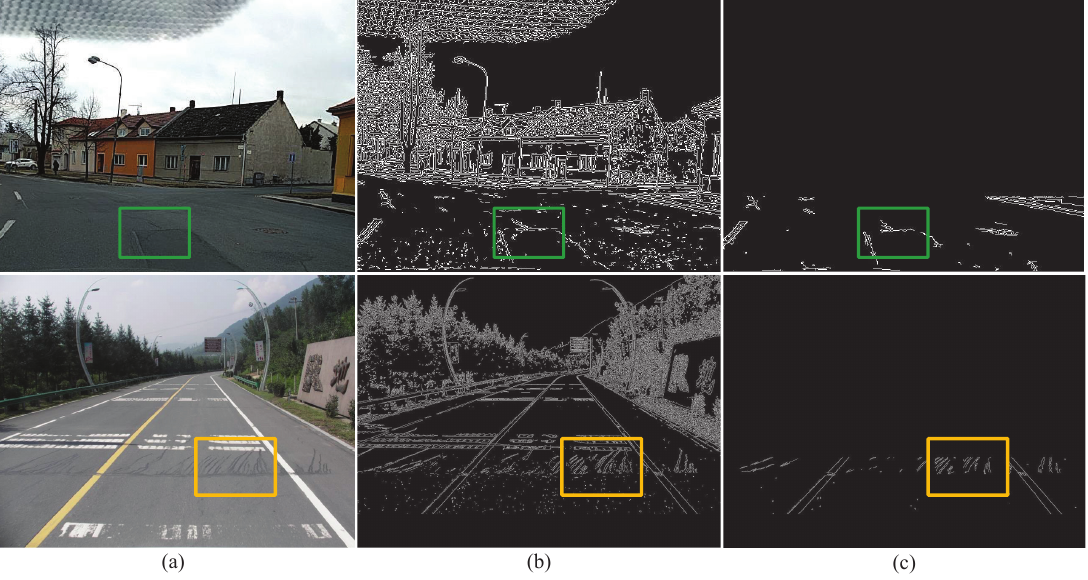
Figure 6. Comparative illustration of edge detection on full graph and half graph: ( a ) raw image; ( b ) edge detection on the whole graph; and ( c ) edge detection on the half